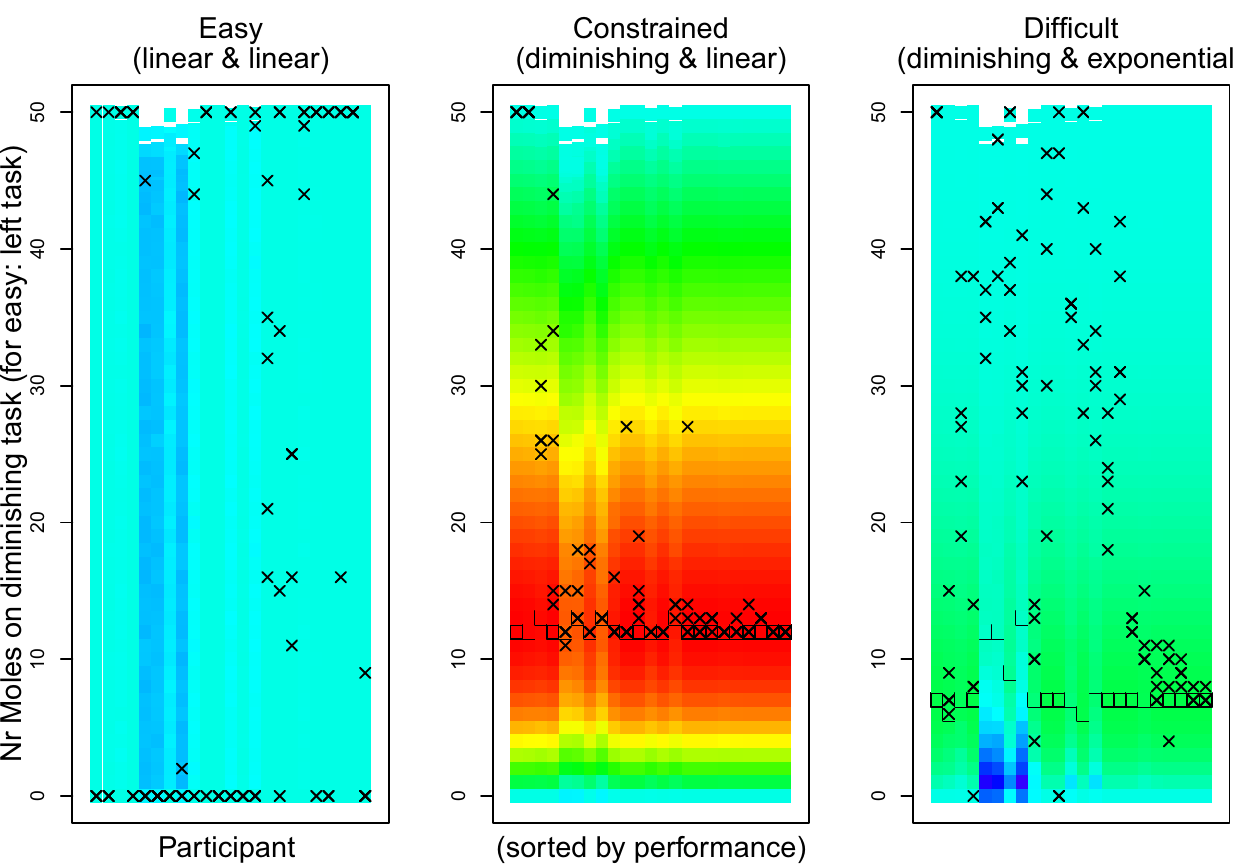
Fig 4. Heatmaps of predicted scores with achieved scores in Experiment 2. The heatmap follows the same format as Fig 4. Square boxes indicate where the most efficient strategy was for the constrained and difficult condition. The pattern is largely the same as before: in the constrained condition there is more consistency in the applied strategy, and most participants apply the efficient